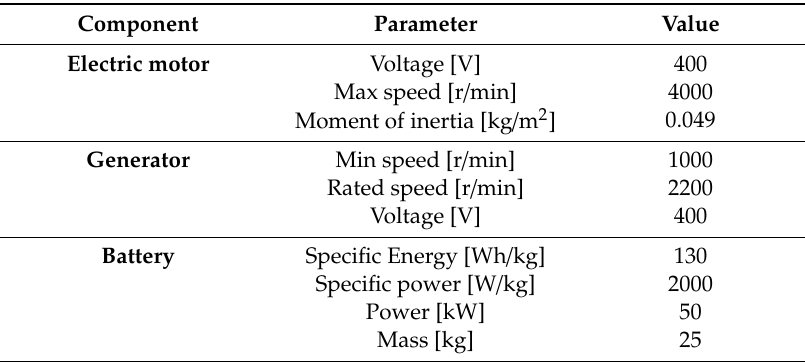
Table 2. Electric components and their main